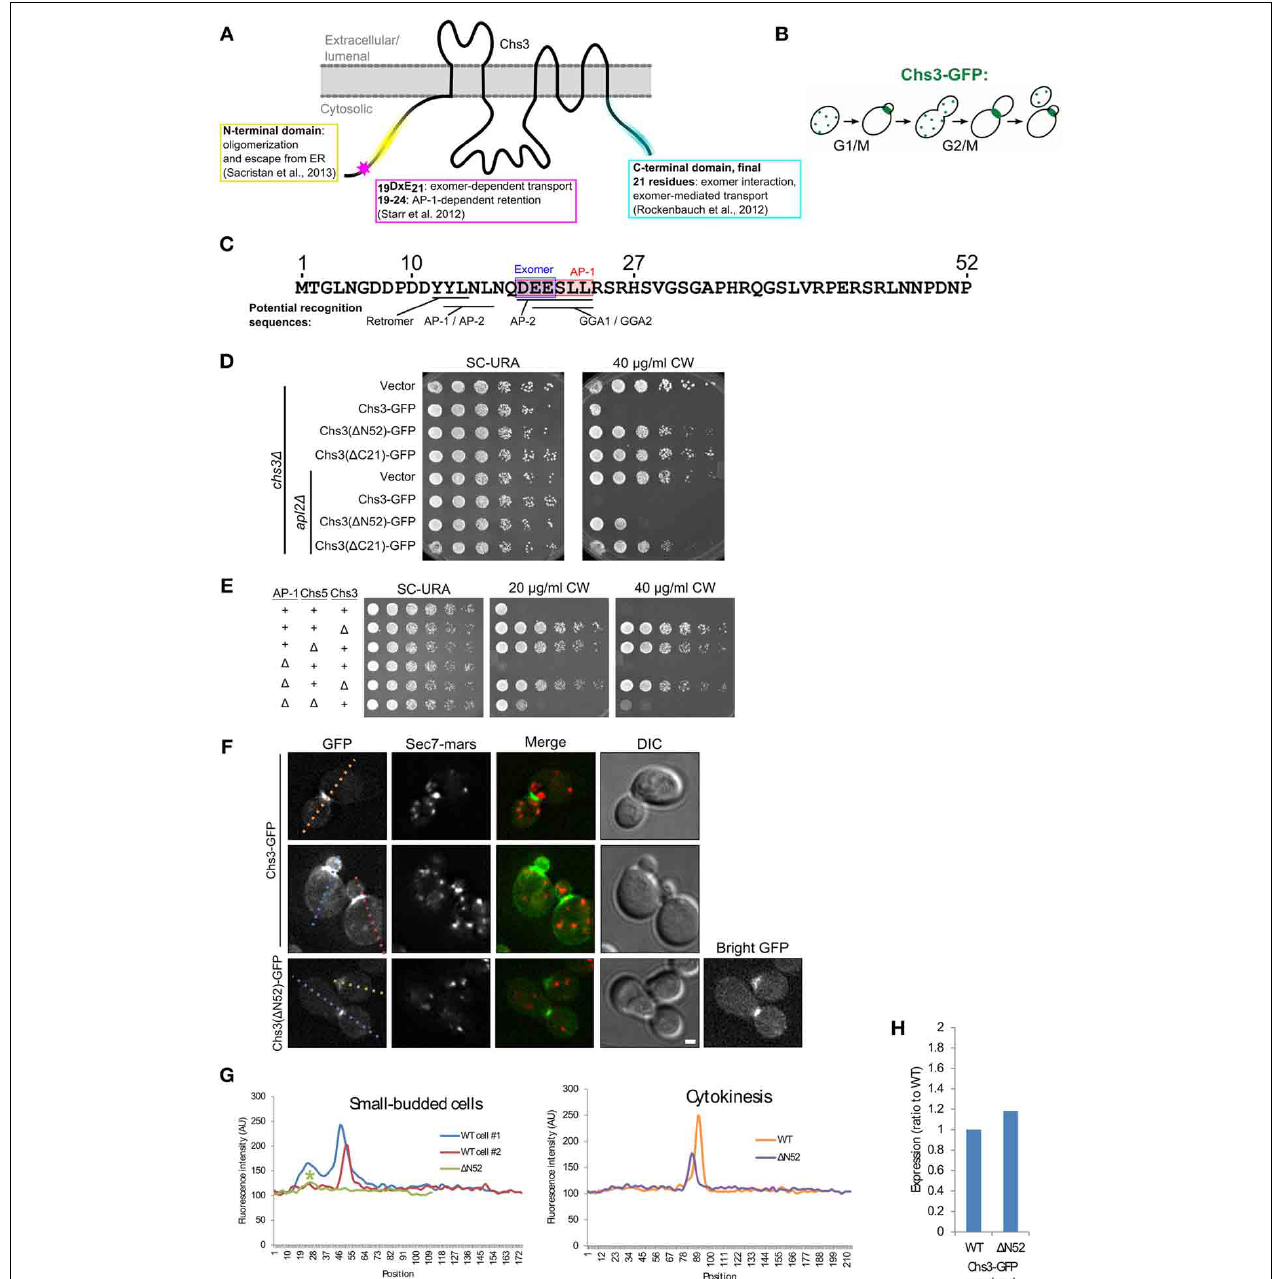
FIGURE 1 | The N-terminus of Chs3 is important for its function and localization. (A) The topology of Chs3 (Sacristan et al., 2013) and regions known to be important for its trafficking. (B) The itinerary of Chs3 throughout the cell cycle. (C) The N-terminus of Chs3 with sites known to be required for adaptor protein interaction (shaded rectangles) and predicted sorting signals for other cargo adaptors. (D) Chs3-GFP mutant plasmids were transformed into both a chs3 (cid:2) SEC7-Mars strain and a chs3 (cid:2) SEC7-Mars apl2 (cid:2) strain and a 10-fold dilution series was plated on indicated media. Plates were imaged after 2 days at 30 ◦ C. See also Figure S2 for additional CW concentrations. (E) Strains with indicated phenotypes were plated on indicated concentrations of CW. All strains are genomic chs3 (cid:2) . Chs3 “ + ” strains contain Chs3-GFP plasmid, and other strains